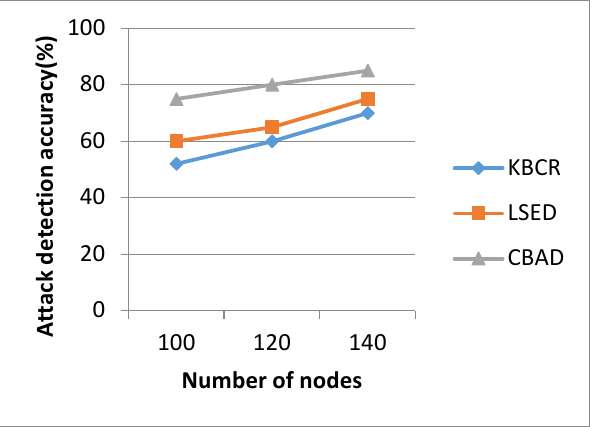
Figure 6. Comparison between the Attack detection accuracy (%) and number of nodes Figure.6 illustrates the comparison performed between the Attack detection accuracy and number of nodes of the novel CBAD and the already available KBCR, LSED methods. It is concluded that the proposed CBAD yields a much better network Attack detection accuracy in comparison with the available KBCR, LSED